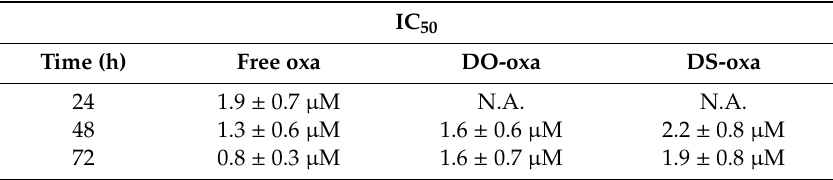
Figure 4. Endocytosis (uptake) levels of fluorescent liposomal formulations. Uptake was measured by cytofluorimetry, after three hours of incubation with 0.20 mg lipids mL culture, in ( A ) HCT-116 cells and ( B ) HUVEC cells. For the measurement, harvested cells were resuspended in PBS containing 1 mg / mL trypan blue, to quench extracellular fluorescence. Untreated cells were used as control (CTRL). Uptake is expressed in arbitrary units (A.U.) derived by mean fluorescence intensity (MFI) after background (CTRL mean fluorescence intensity (MFI), i.e., cell auto-fluorescence) subtraction and normalization with specific fluorescence intensity of each liposome type (see Materials and Methods). Experiments were performed in three independent replicates. Error bars represent standard deviations. Statistical significance was calculated by one-way two-tailed t -test. Table 2. Inhibitory concentration (IC 50 ) of free oxaliplatin and oxaliplatin-loaded liposomes. IC 50 values were calculated by GraphPad Prism software through interpolation with curves of Figure 5. Statistical significance was calculated by the t- test; comparisons DO-oxa vs. DS-oxa, DO-oxa vs. Free Oxa, DS-oxa vs. free oxa were significant at 48 h and 72 h ( p <